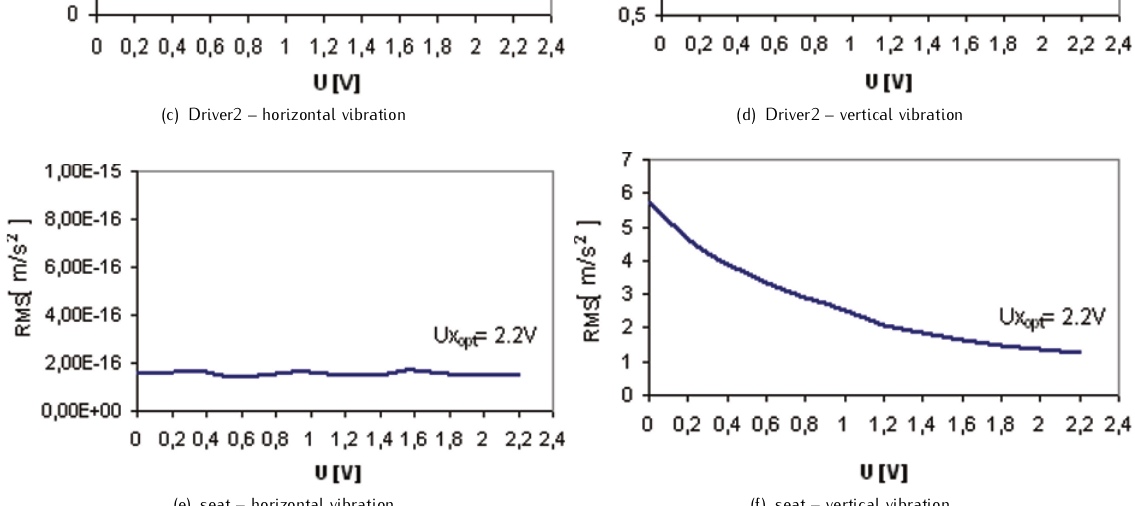
Fig. 8. Average (mean square) values of accelerations of four human body structures as function of MR control voltage: (a) horizontal vibrations (driver 1), (b) vertical vibration (driver 1), (c) horizontal vibration (driver 2), (d) vertical vibration (driver 2), (e) horizontal vibrations (seat), (f) vertical vibration (seat).